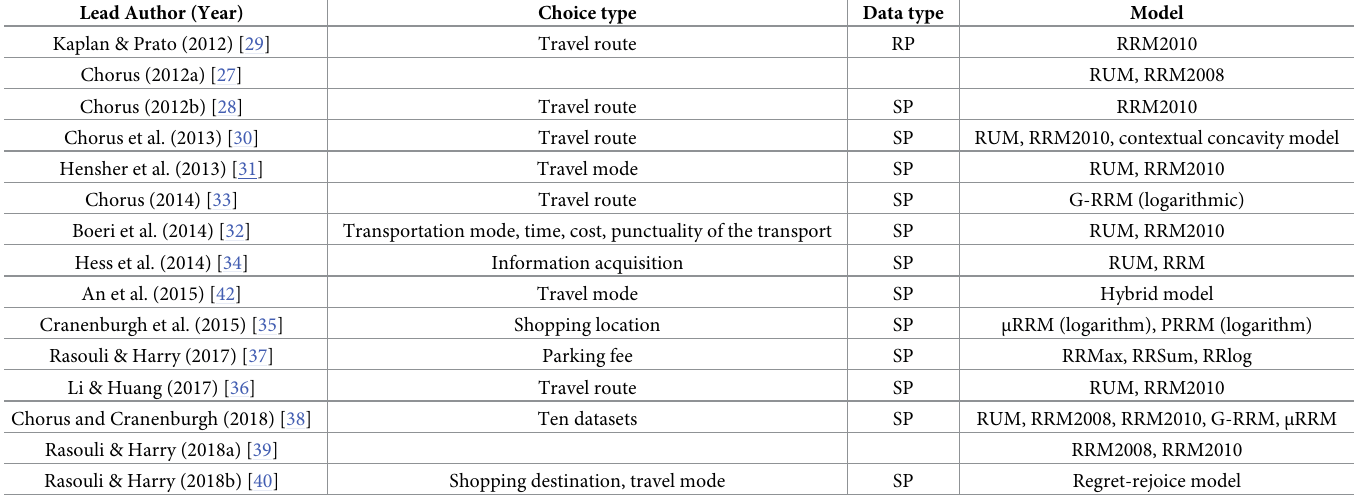
Table 1. Summary of feature used in selected